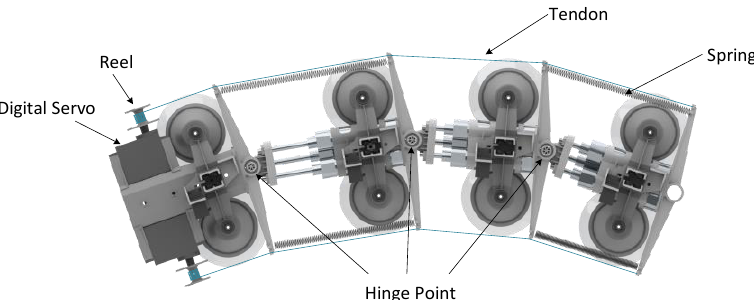
Figure 3. Top view of the overall structure of the steering mechanism. The two adjacent segment units are connected by a bearing hinge. There are two tendons on the both sides of the robot.